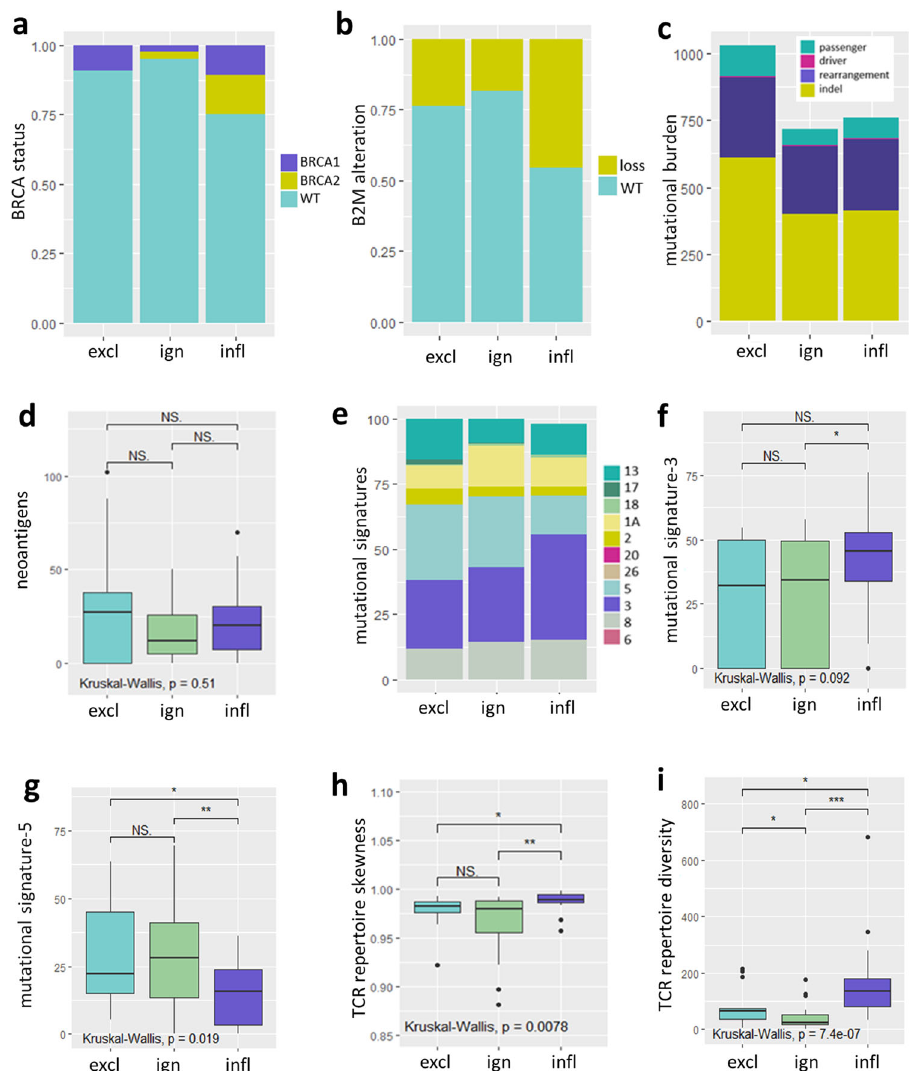
Fig. 3 Genomic features of spatial phenotypes. The following parameters were tested for differential presence in spatial phenotypes (determined by the gene-classi fi er) in TNBC: a BRCA status (proportion, BRCA1: purple, BRCA2: yellow, WT: cyan). b Loss of β 2-microglobin (copy number, B2M-loss: yellow, B2M-wt: cyan). c Total number of different types of mutations (passenger mutations: cyan, driver mutations: magenta, structural rearrangements: purple, indels: yellow). d Total number of predicted neo-antigens. e Proportions of most abundant mutational signatures. f , g Frequencies of signatures-3 and 5. h TCR repertoire skewness (based on the gini-simpson index). i Total number of different TCR-V β reads. For all above parameters Cohort C ( n = 66 TNBC, comprising n = 13 excluded, n = 29 ignored, and n = 24 in fl amed) was used, spatial phenotypes were assigned according to the classi fi er. All boxplots display the median with 25th – 75th percentile, range, and outliers are displayed as dots. Signi fi cant differences are: *** p < 0.001; ** p < 0.01; * p < 0.05, NS, p > 0.5 (Kruskal – Wallis, one-sided). Source data are provided within the source data fi